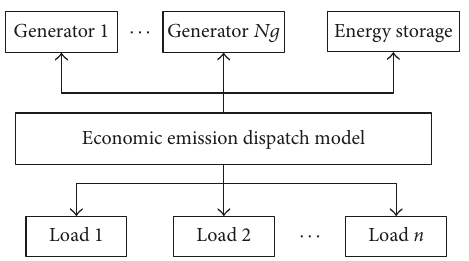
Figure 1: Scheme of economic emission dispatch